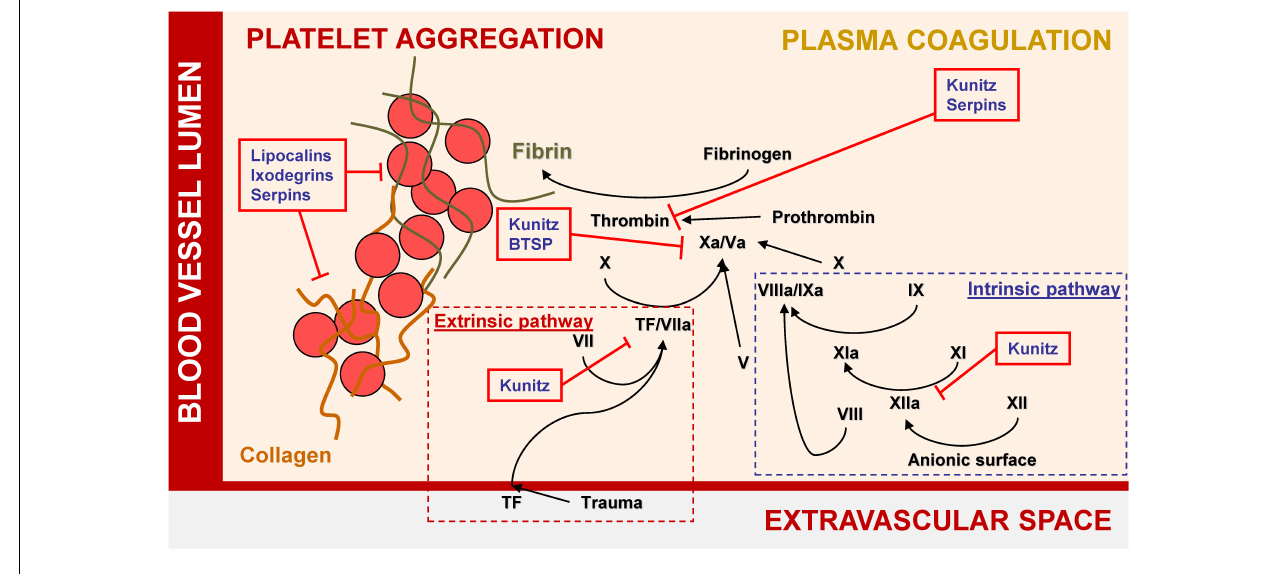
FIGURE 1 | Major tick salivary protein families and their roles in hemostasis.